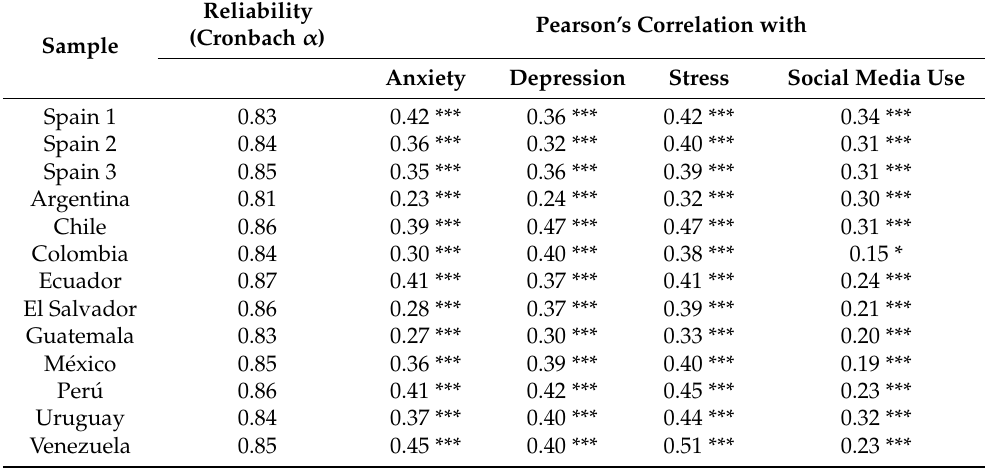
Table 3. Reliability and concurrent validity of